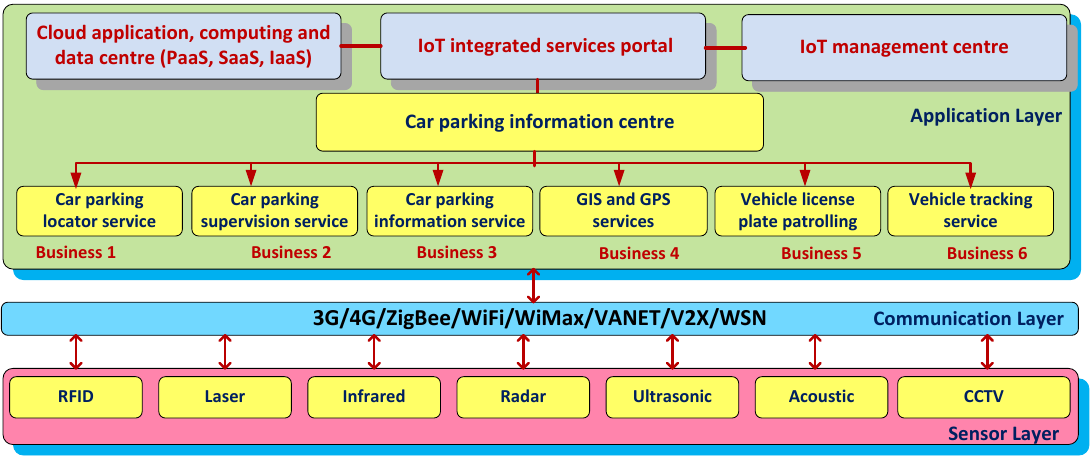
Figure 4. An IoT intelligent car parking system for a Smart